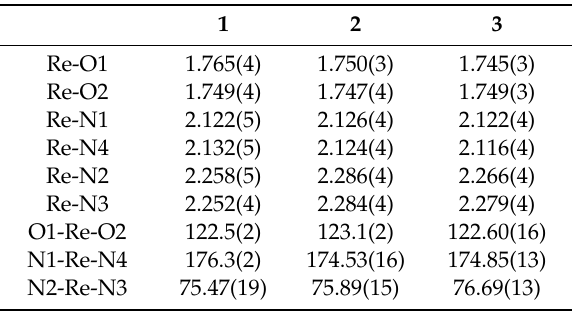
Table 1. Selected bond distances (Å) and angles ( ◦ ) of cis -dioxo-rhenium complexes, cis -[(S,S-BPBP)ReO 2 ]PF 6